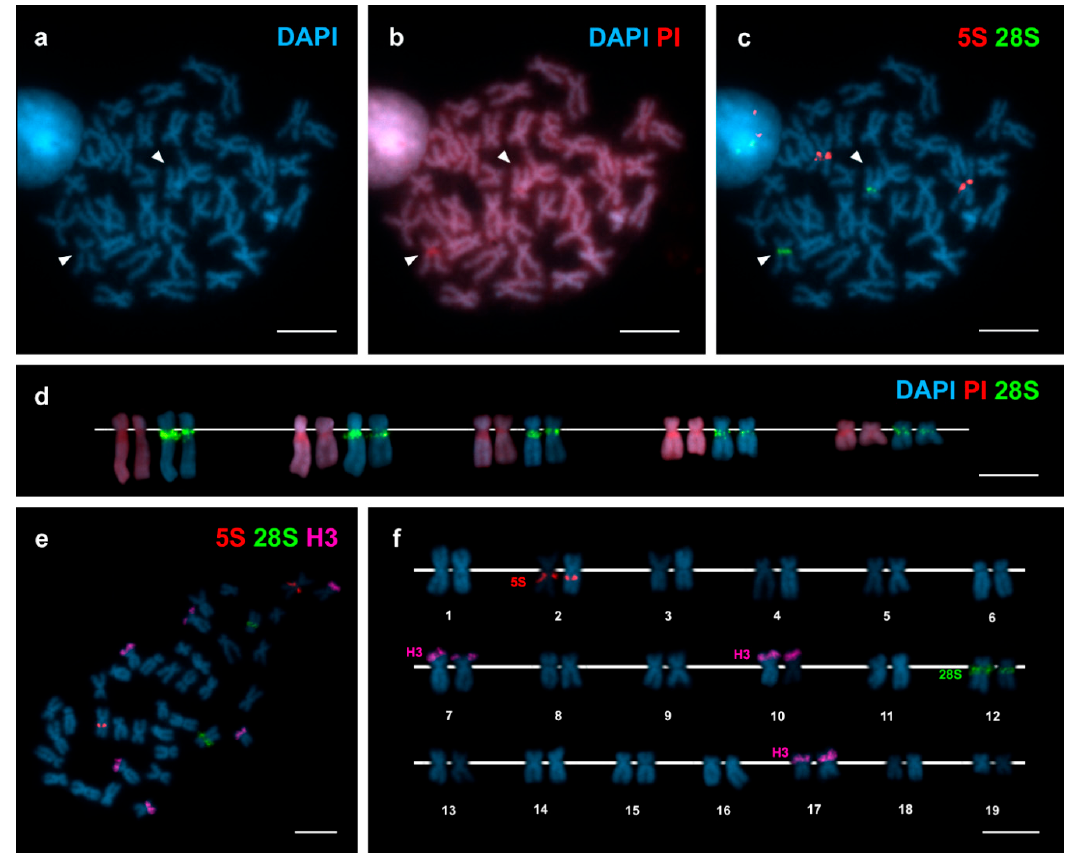
Figure 1. Chromosomal mapping of 28S rDNA, 5S rDNA and H3 histone gene clusters in Arctica islandica . Mitotic metaphase plate stained with diamidino-2-phenylindole (DAPI) ( a ) and DAPI/ propidium iodide (PI) ( b ) shows DAPI negative regions (arrowheads) subcentromeric to the long arms of a single chromosome pair; these regions are red after DAPI/PI staining. Hybridization of the same metaphase plate with major and minor rDNA probes labelled differently ( c ) shows major rDNA signals (28S, green) coincident with the DAPI negative regions and minor rDNA signals (5S, red) subcentromeric to the long arms of a metacentric chromosome pair. As shown in ( d ), the sizes of the DAPI negative regions and the 28S rDNA signals, differed between homologous chromosomes irrespective of their condensation degrees. Sequential fluorescent in situ hybridization (FISH) using major and minor rDNA and H3 histone gene probes on the same metaphase plate ( e ) and the corresponding karyotype ( f ), show H3 histone gene signals (H3, magenta) on the short arms of chromosome pairs 7, 10 and 17. Scale bars, 5 μ m.